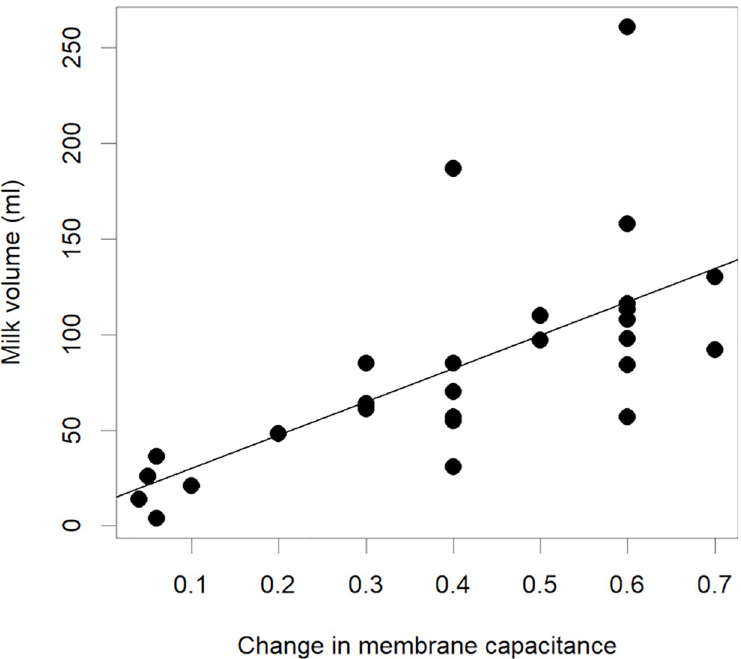
Fig 5. The relationship between the proportionate change in membrane capacitance of the ipsilateral breast and milk volume removed from the breast for all subjects.